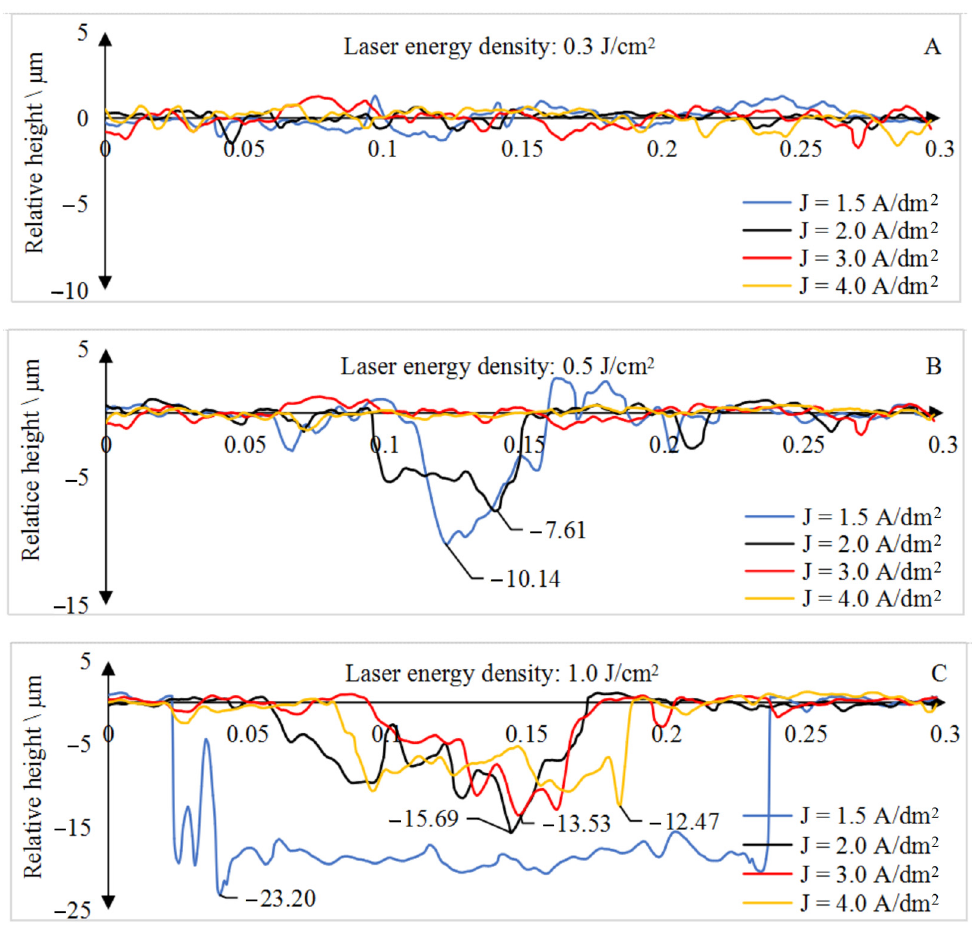
Figure 12. Damage pits profile after laser irradiation with different current densities. The laser energy density in ( A ) is 0.3 J/cm 2 ; ( B ) is 0.5 J/cm 2 ; ( C ) is 1.0 J/cm 2 . Table 8. Width and depth of laser damage pit of current density